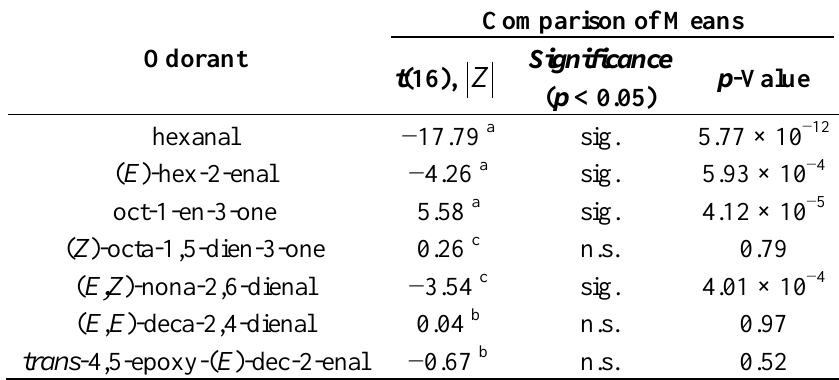
Table 4. Statistical data on comparison of means between formulations with and without antioxidants (week 0). t and Z as critical values of the respective statistical test.